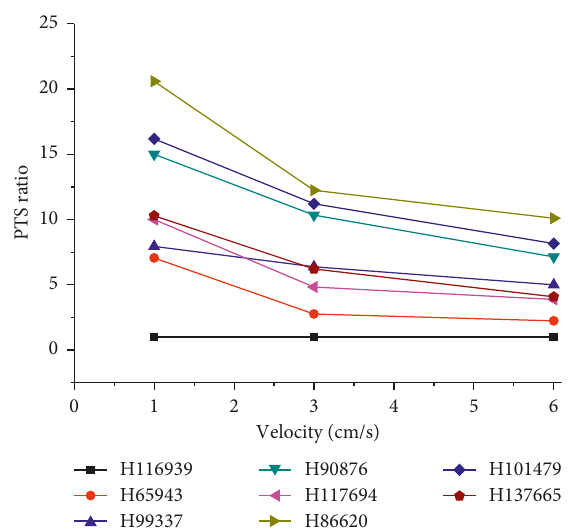
Figure 26: The PTS ratio curve of local members under different peak particle